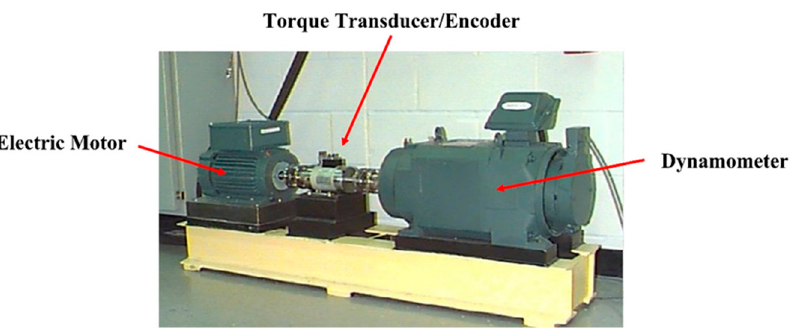
Figure 4. Apparatus used in Case Western Reserve University.